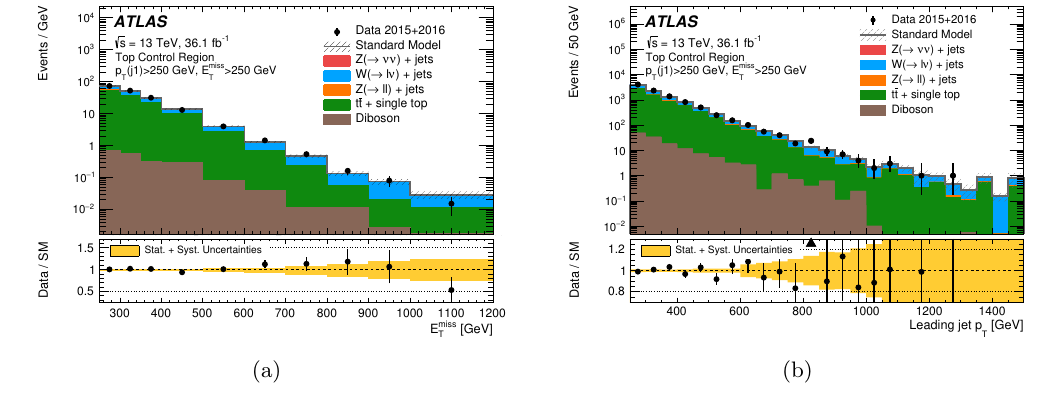
and (b) leading-jet p T distributions in the top control region, Figure 3 . The measured (a) E miss T for the E miss > 250 GeV inclusive selection, compared to the background predictions. The latter T include the global normalization factors extracted from the (cid:12)t. The error bands in the ratios include the statistical and systematic uncertainties in the background predictions as determined by the binned-likelihood (cid:12)t to the data in the control regions. The last bin of the E miss and leading-jet T p T distributions contains over(cid:13)ows. The contributions from multijet and non-collision backgrounds are negligible and are not shown in the